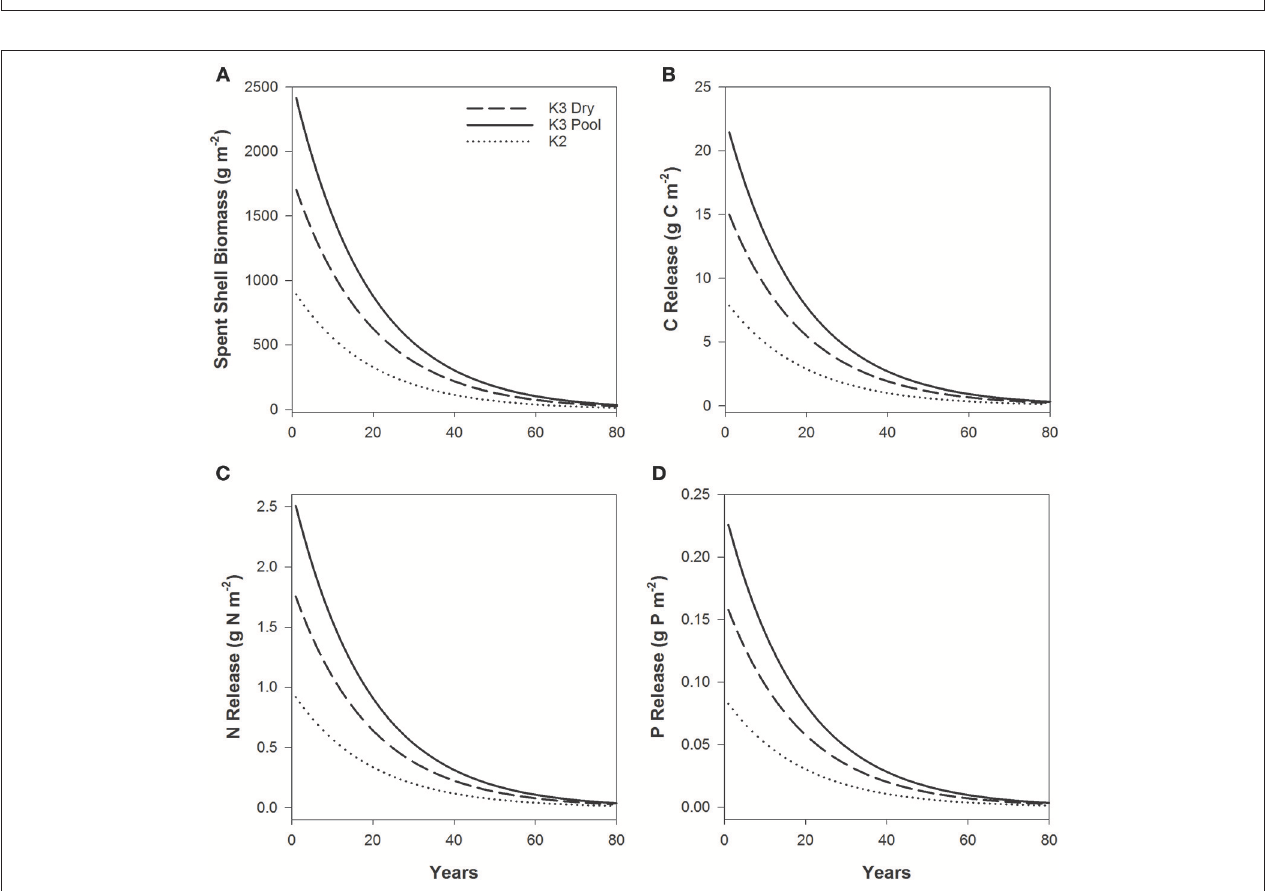
FIGURE 6 | Shell decomposition (A) of spent mussel shells following the mass mortality event as a result of low flow and high temperature conditions at 3 sites in the Kiamichi River, OK and the resultant release of carbon (B) , nitrogen (C) , and phosphorus (D) from the shell material over time. Shell decomposition is modeled based on the shell decomposition rates and shell stoichiometry values from Atkinson et al. (2018) and the empty shells sampled from Southeastern Oklahoma in the drought of 2011.